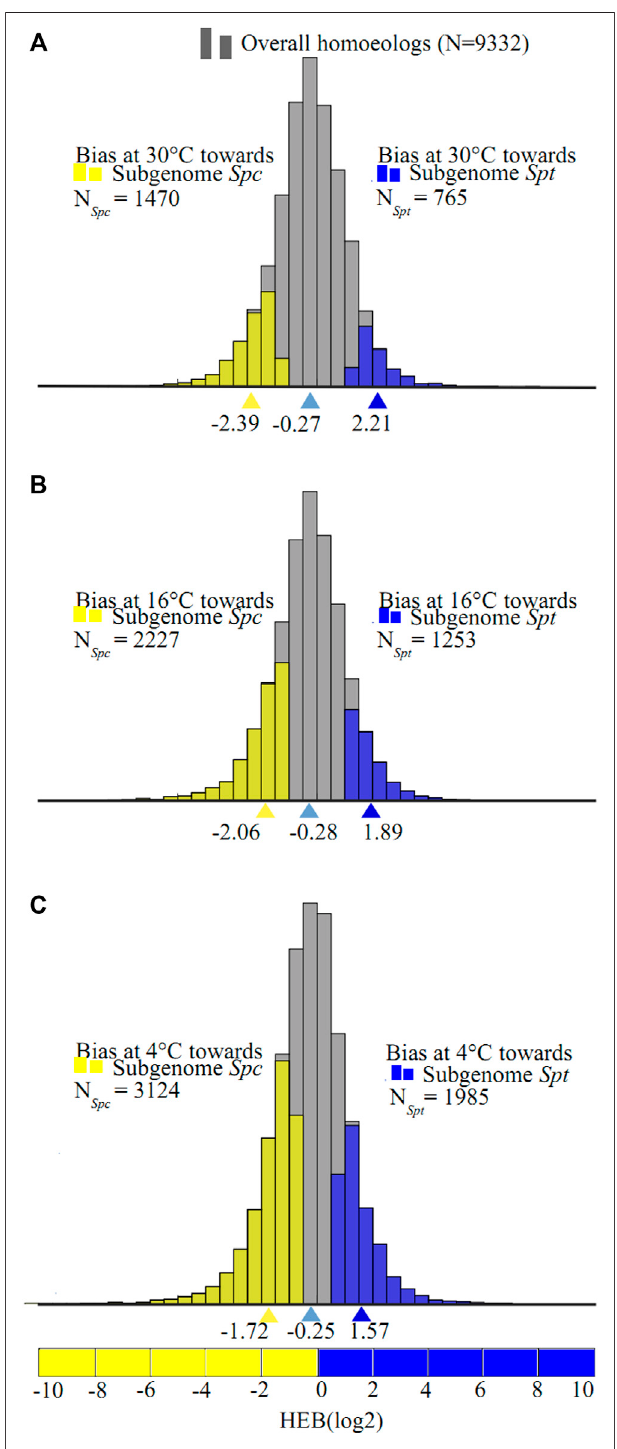
FIGURE 4 | Likelihood ratio test for homeologs expression bias (HEB) in the F1 hybrids between Sphagneticola trilobata ( Spt ) and S. calendulacea ( Spc ) upon consecutive chilling stress ( (A) 30 ° C, (B) 16 ° C, and (C) 4 ° C). The distribution of expression bias (B) for all testable homeologs in the F1 hybrid indicated by gray histograms, and homeolog pairs with signi fi cant expression bias toward Spt- like homeolog are shown in blue histograms, and ( Continued )